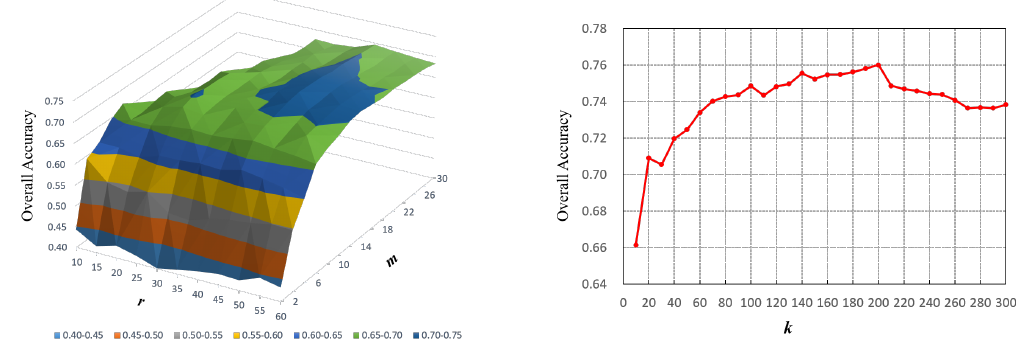
Figure 5. Parameter analysis of ( a ) OAs with simultaneously varying the first-stage subspace projection dimensionality r and the second-stage subspace projection dimensionality m on Indian Pines , and ( b ) OAs with varying the number of neighbors k in the computation of adjacency